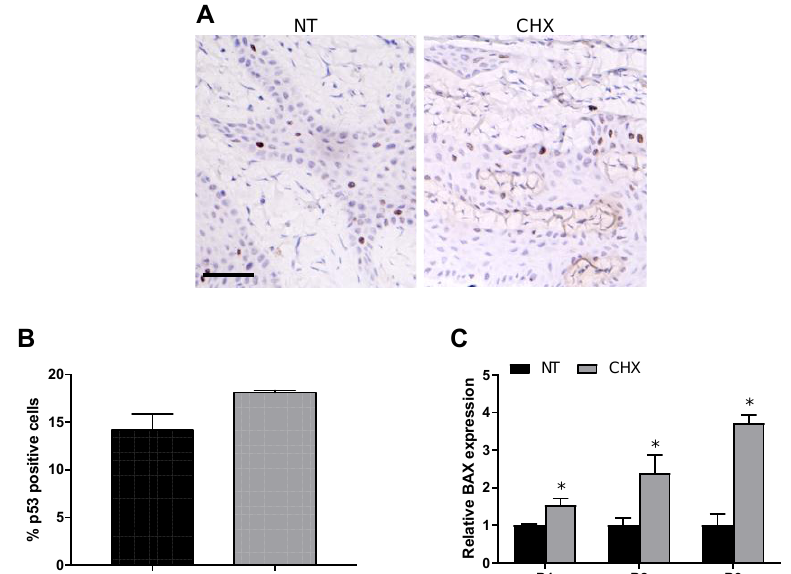
Figure 5. CHX shows a proapoptotic effect in gingival tissues. ( A ) Representative photomicrographs of sections of NT and CHX gingival biopsies stained with anti-p53 antibodies. Scale bar 50 µ m. ( B ) Mean percentage of p53 immunopositive cells. ( C ) Quantitative real-time PCR analysis of BAX mRNA expression in NT and CHX biopsies of three patients. Relative mRNA levels are shown as fold value of the NT levels. mRNA levels were normalized to GAPDH mRNA expression. Each experiment was performed in triplicate. Error bars represent standard deviations. * p < 0.05 vs. NT.